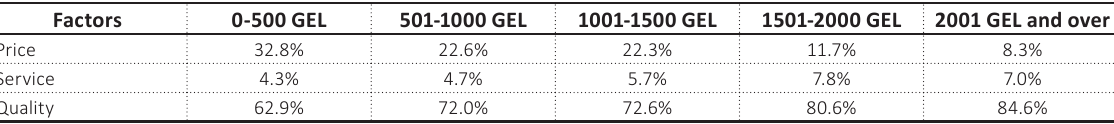
Table 5. Results to the question: In general, which of the following factors encourages you to choose one of two similar products? Seen in terms of revenue Source: Constructed by the authors based on the data of the